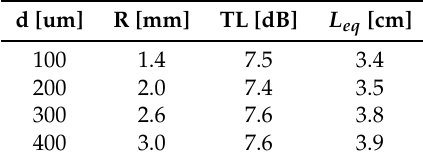
Table 1. Optimal cylinder radius for different access waveguide widths, as well as the corresponding equivalent path length and total transmission loss. It can be seen that both the equivalent path length and total transmission loss are nearly constant at optimal